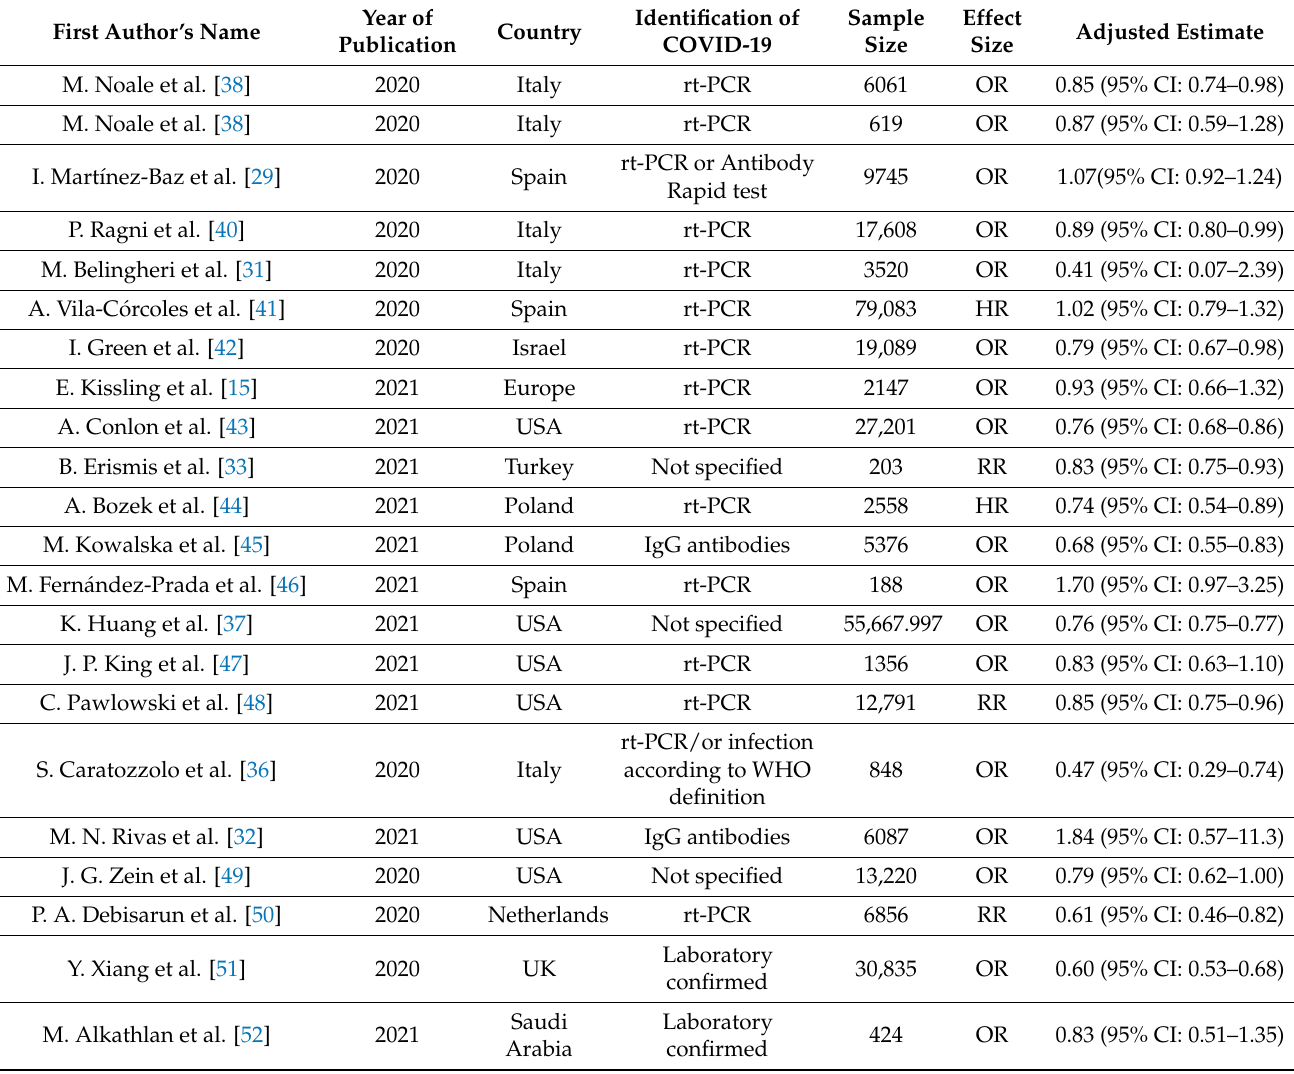
Table 1. Baseline characteristics of the 21 publications, involving 22 studies that assessed the associa- tion between influenza vaccination and SARS-CoV-2 infection.